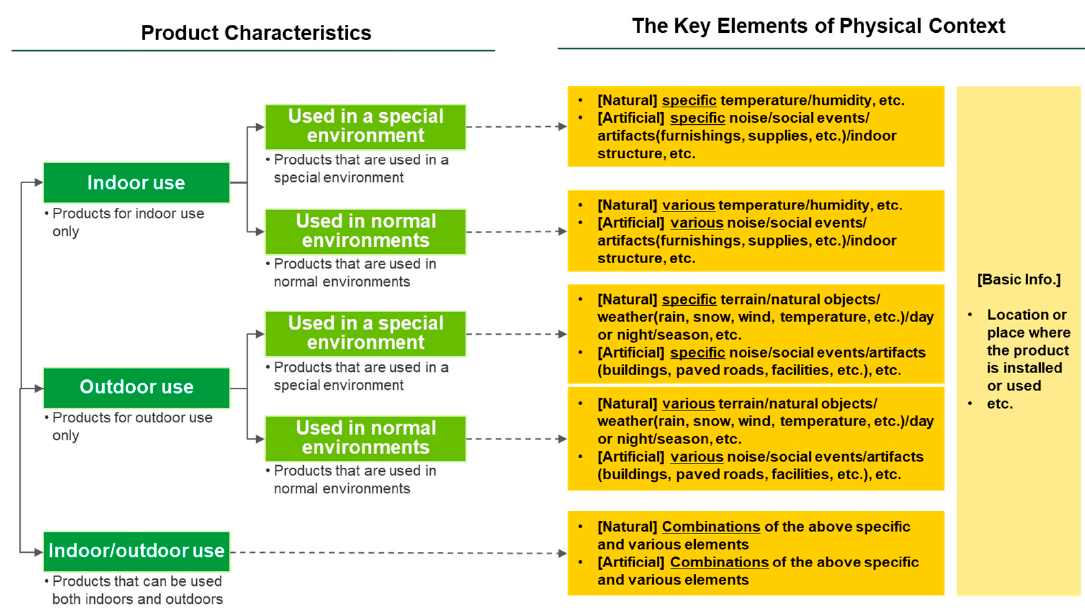
Figure 3. The Framework for the Context Analysis of a Product (Physical Context).